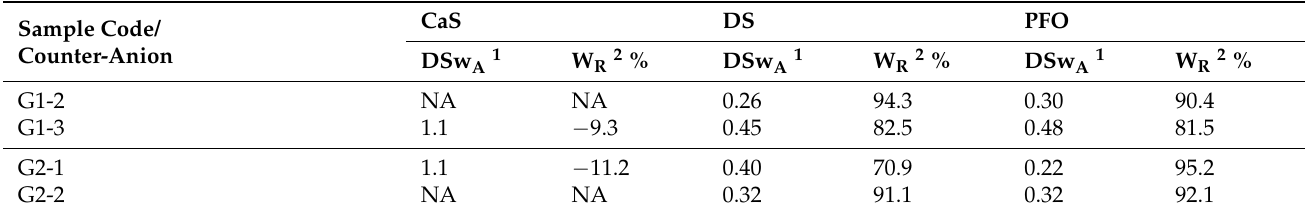
Table 2. Swelling properties of G1 and G2 hydrogels after the anion exchange.